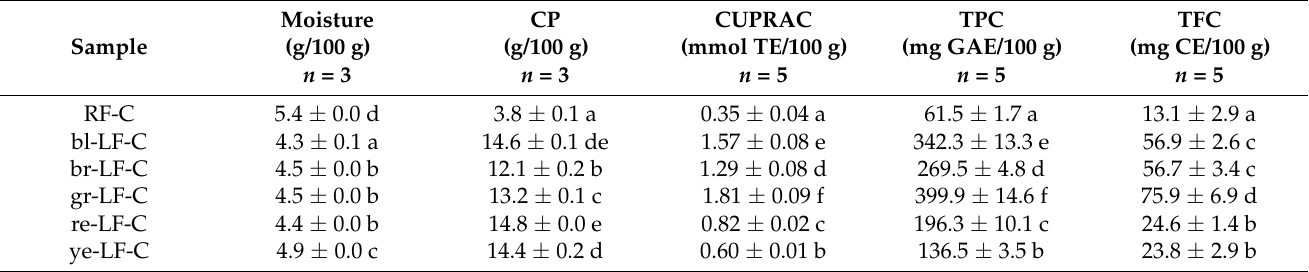
Table 7. Moisture and crude protein (CP) content, cupric ion-reducing antioxidant capacity (CUPRAC), total polyphenol (TPC) and total flavonoid (TFC) content of lentil and rice